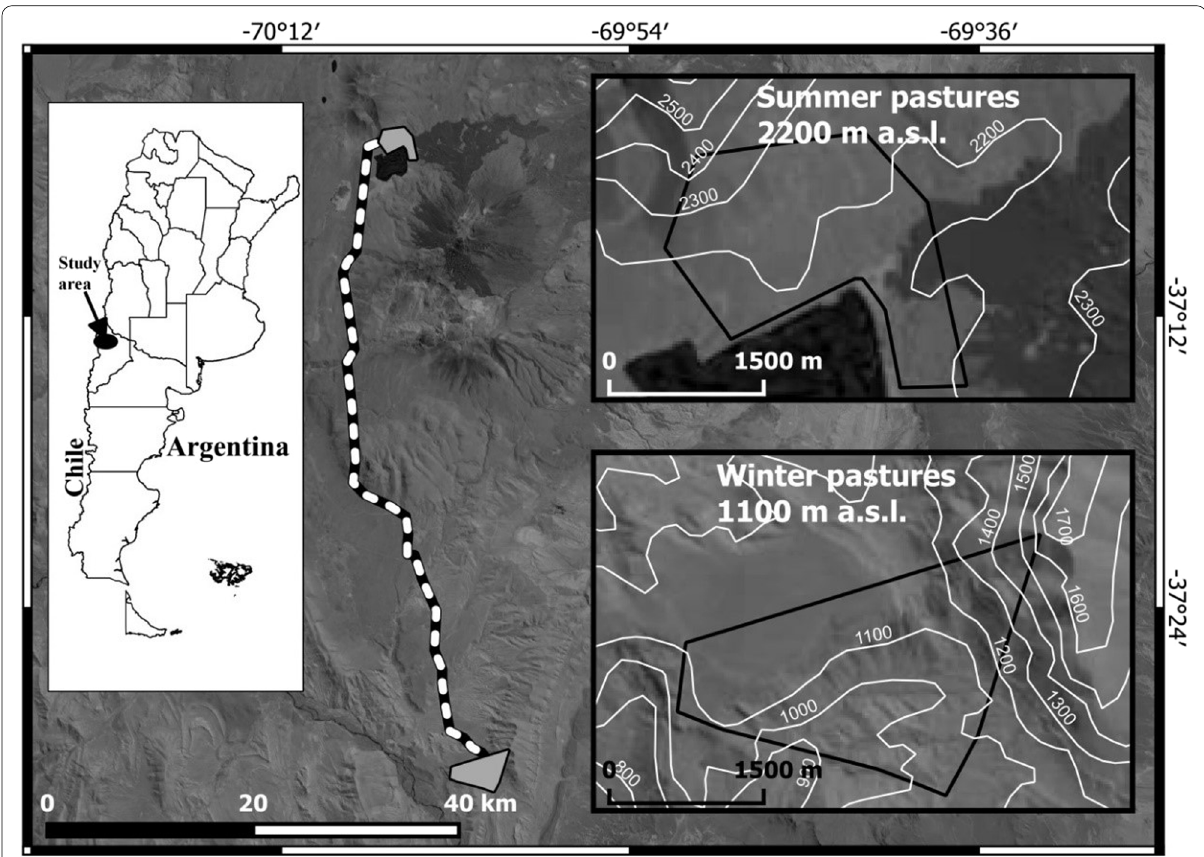
Fig. 1 Study area: Argentina (left); trans-human movement of goats (centre) and grazing areas